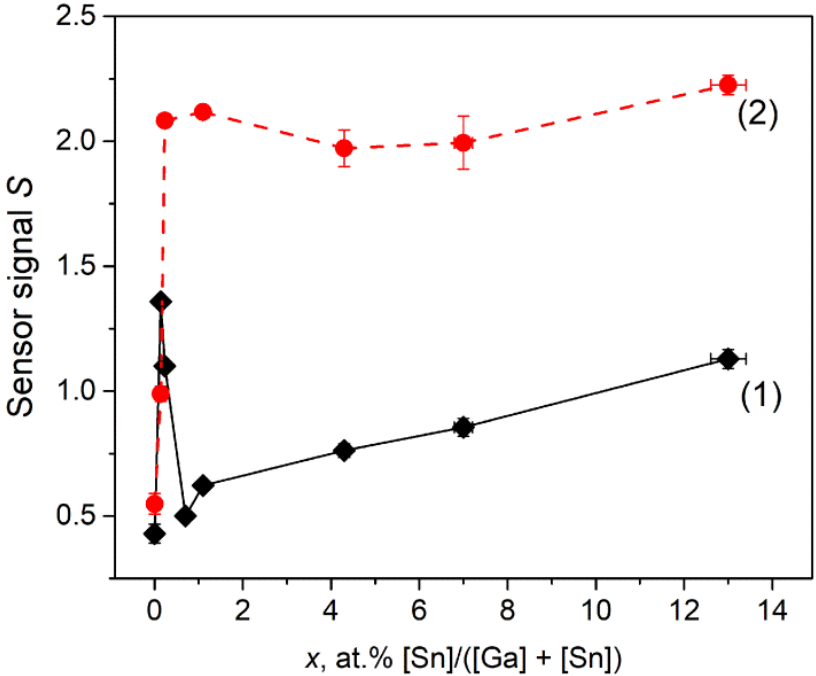
Figure 12. Sensor signal S to 256 ppm CO as a function of Sn content x for samples obtained by annealing at ( 1 ) 750 and ( 2 ) 1000 °C. The measuring temperature is 500 °C.